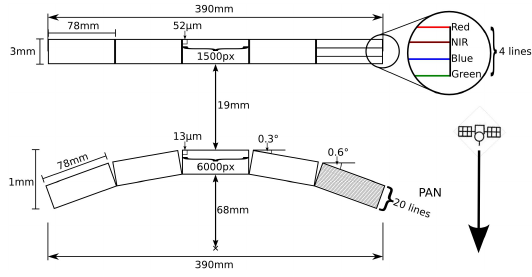
Figure 3: Focal plane assembly Pl´eiades As shown in fig. 4 the RapidEye focal plane assembly consists of five separate CCD lines – one for each band. They are grouped in two mounts: the blue and green on one and the red, red edge and the near infrared band on the second.